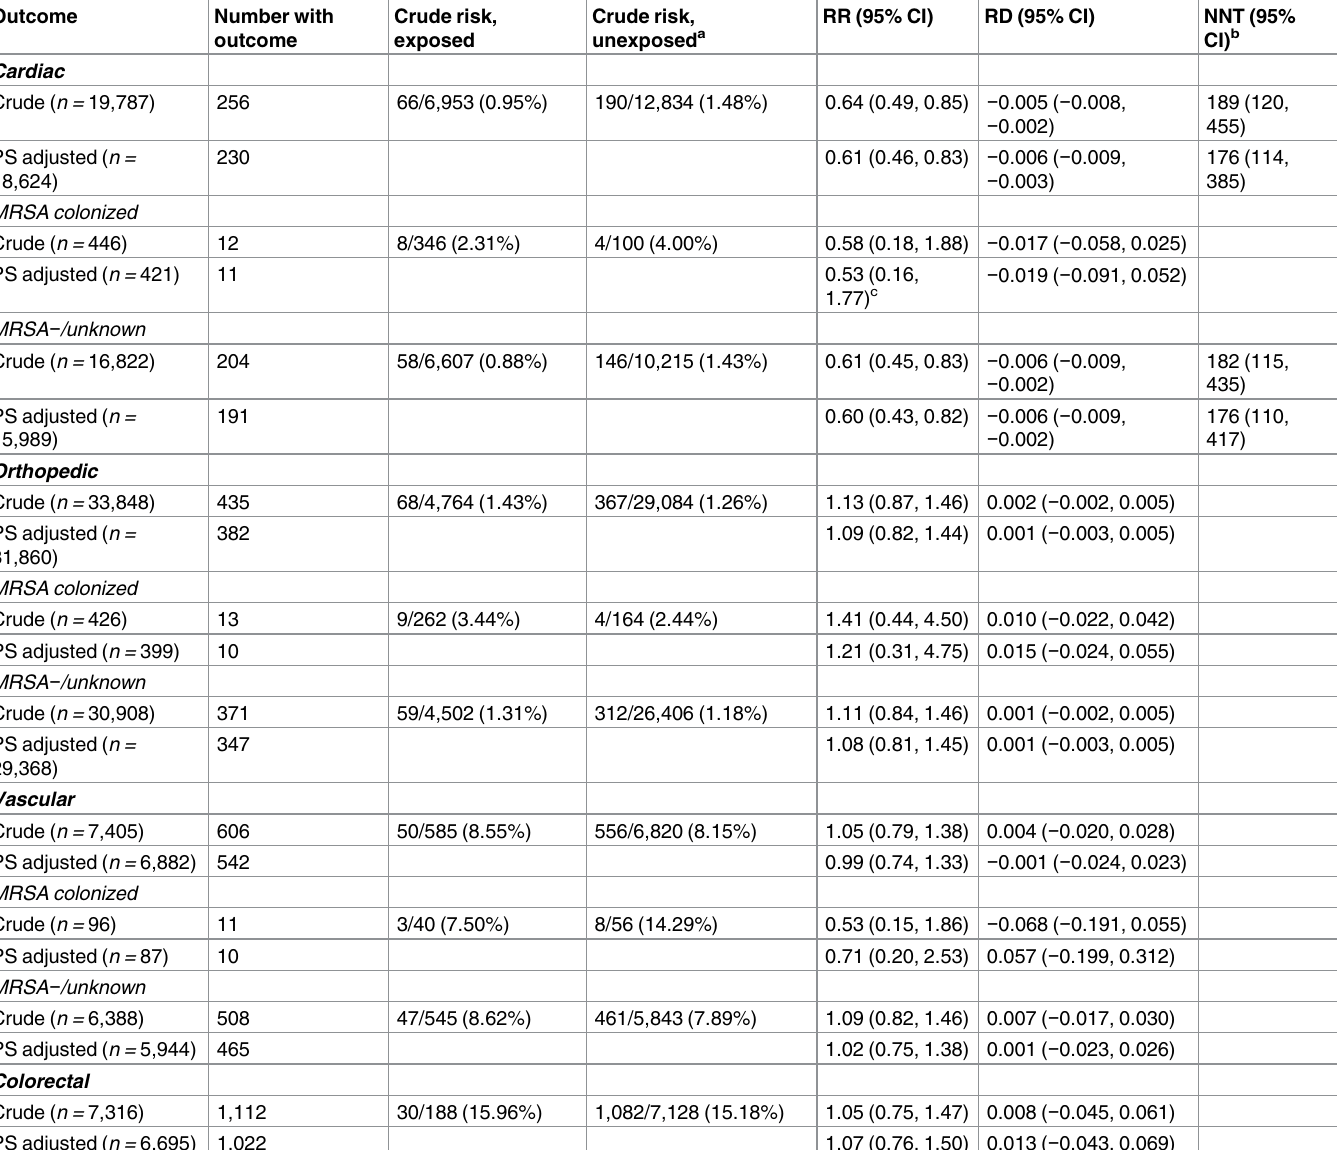
Table 2. Results of propensity-score-based analysesof the effect of antibiotic regimen on 30-day surgical site infection